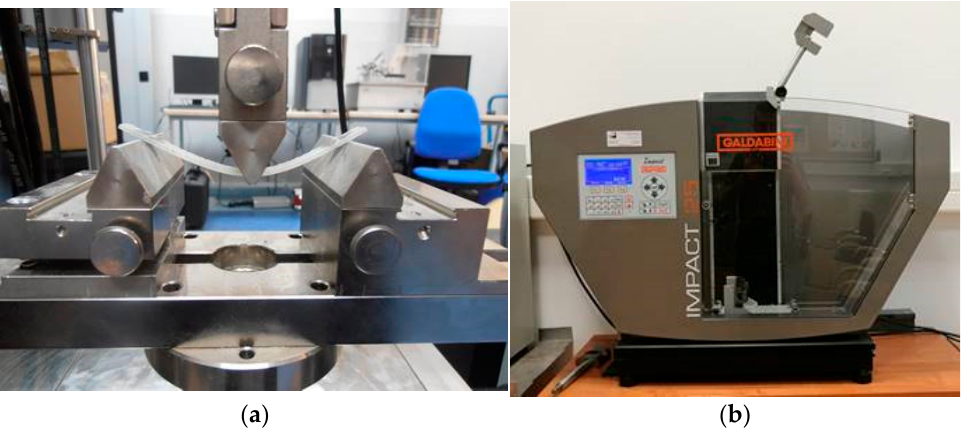
Figure 2. The examples of equipment used in the experiments: ( a ) flexural strength measurement with Zwick/Roell Z100; ( b ) impact strength measurement with Impact 25.